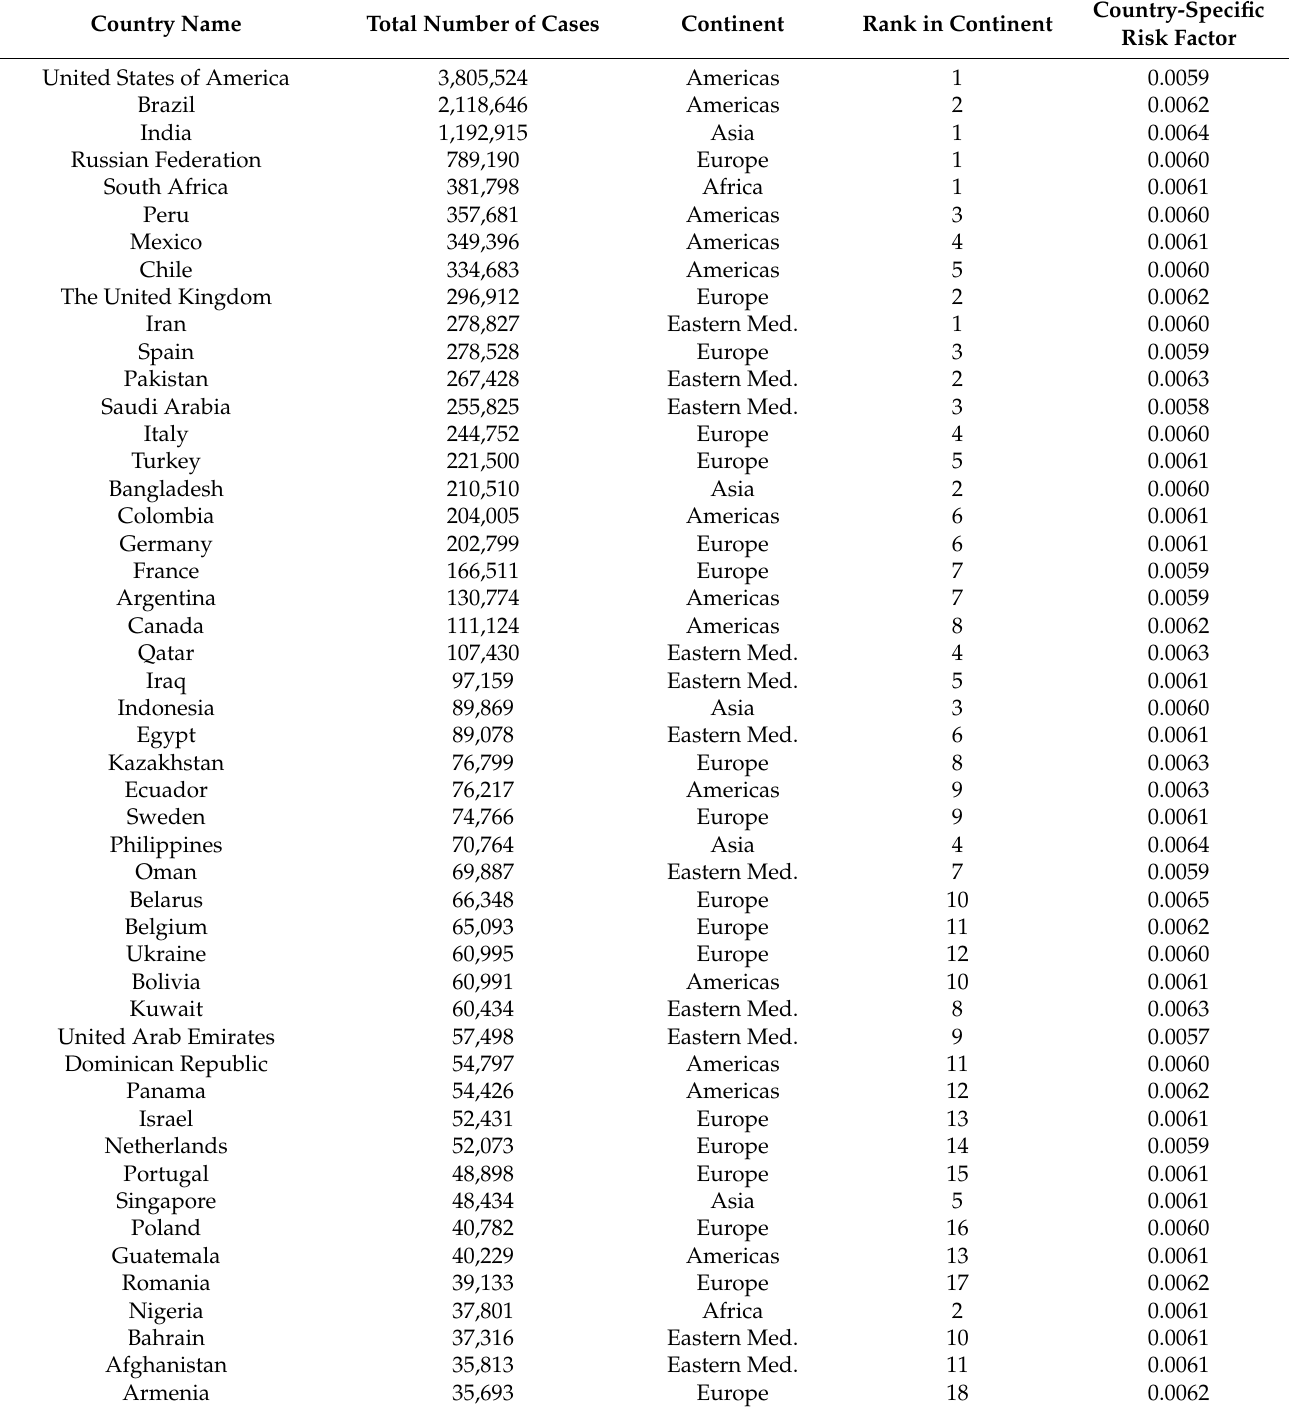
Table A1. A list of the 164 countries considered in this study, their total number of cases as of 22 July 2020, their corresponding continents, their ranks in their continents, and their estimated country-specific risks. Countries are listed in descending order of the total number of